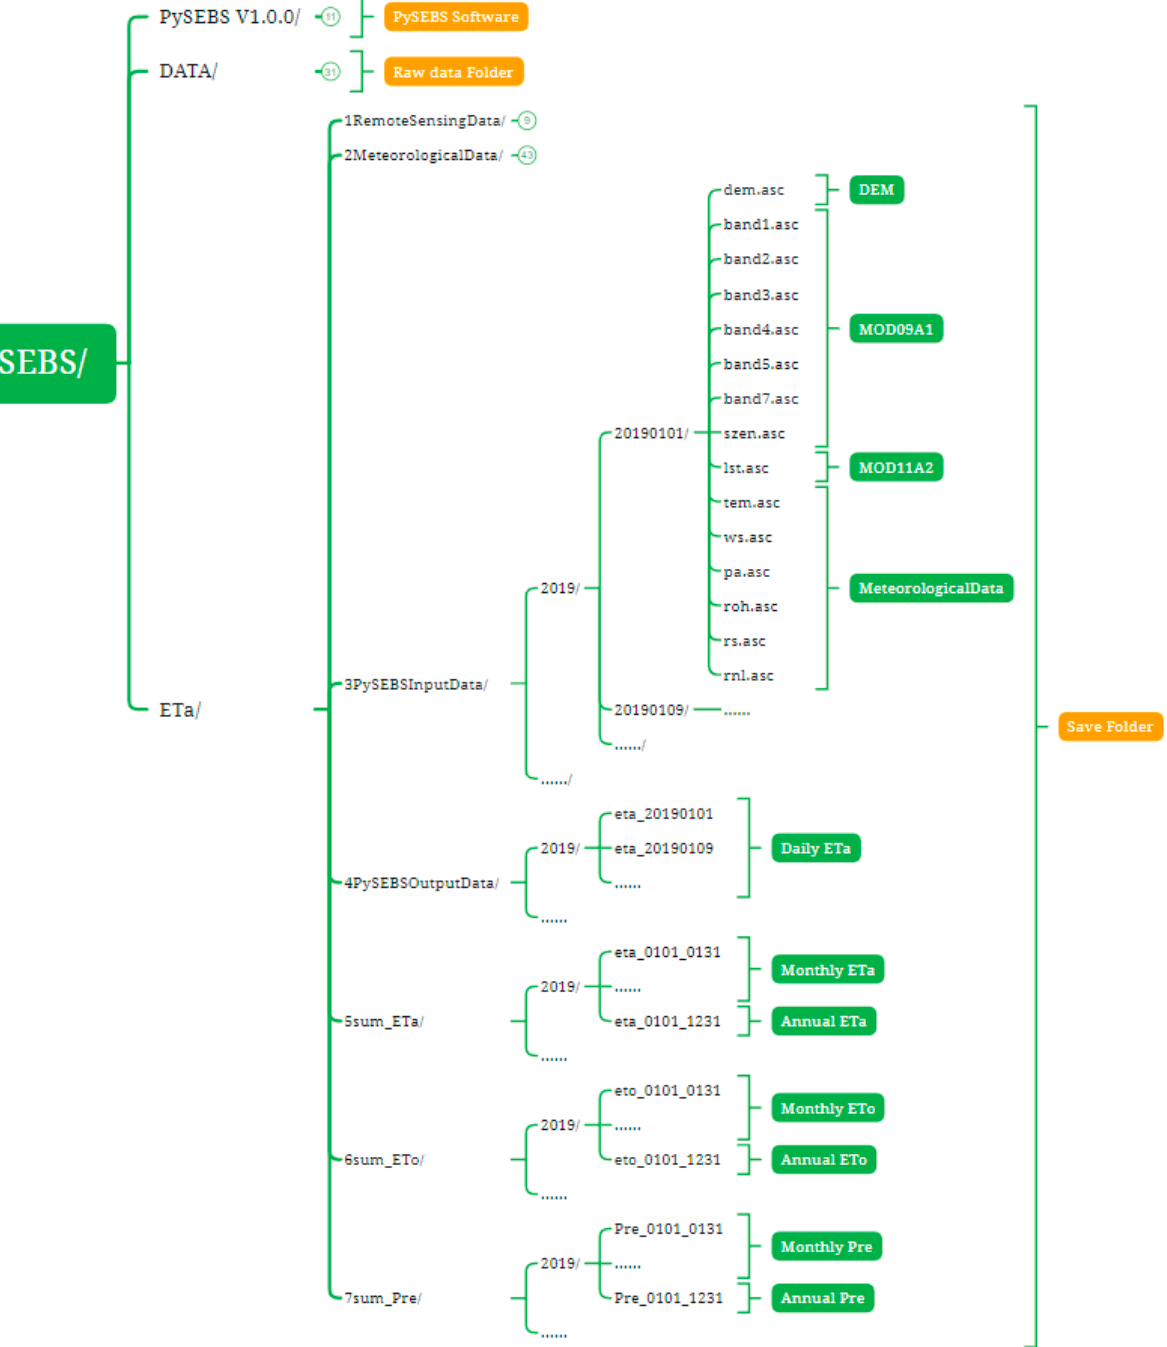
Figure 6. Schematic diagram of the structure of folders 3PySEBSInputData/, 4PySEBSOutputData/, and 5sum_ETa/, 6sum_ETo/, and 7sum_Pre/.